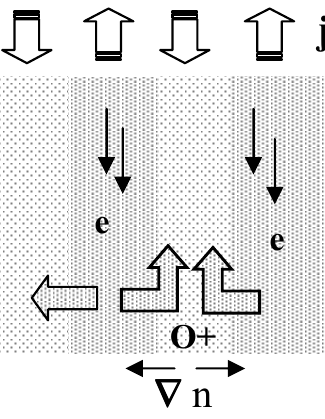
Fig. 9. A schematic drawing which illustrates two pairs of anti- parallel currents, enhanced O + production inside the regions of the electron precipitation and O + outflowing from the overdense